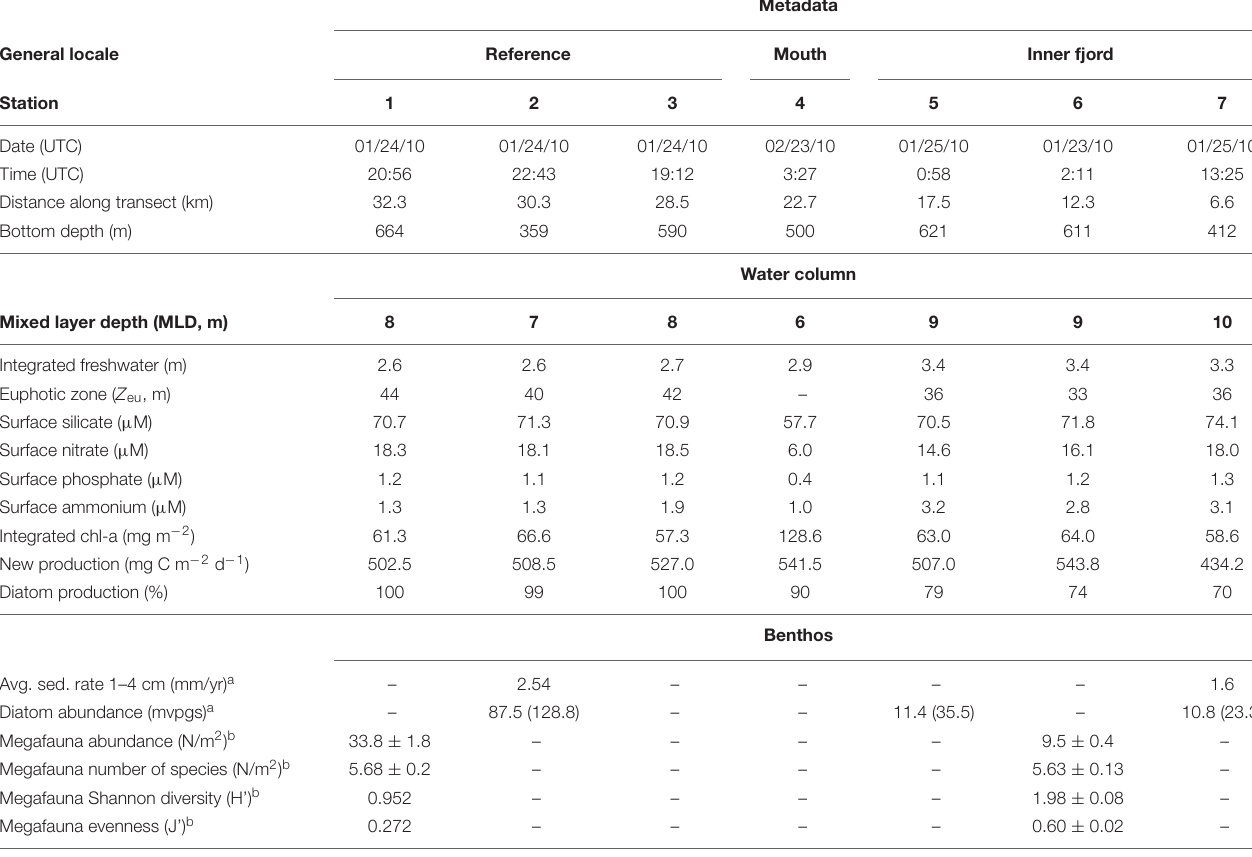
TABLE 1 | Measured and derived properties of stations sampled in Barilari Bay during